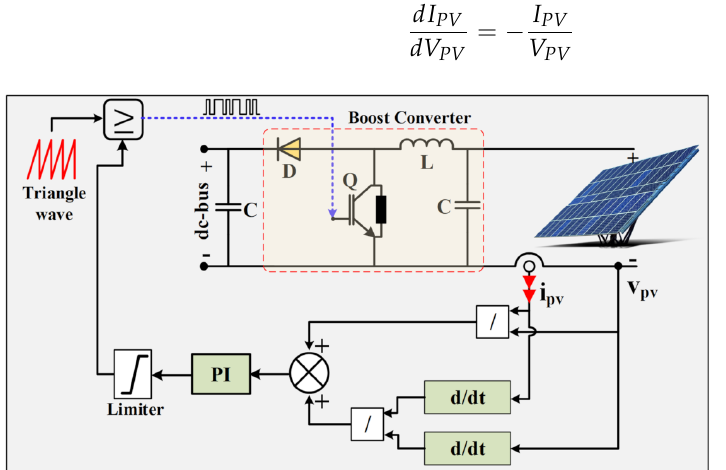
Figure 5. MPPT control of the PV system.